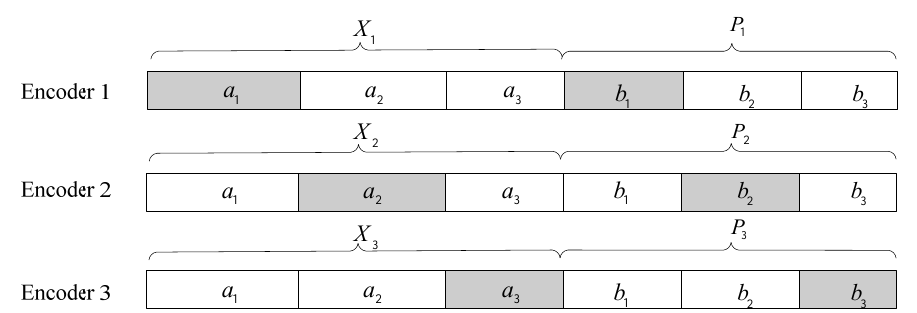
Figure 6. Structures of the outputs of the encoders: Only the gray squares are transmitted for each